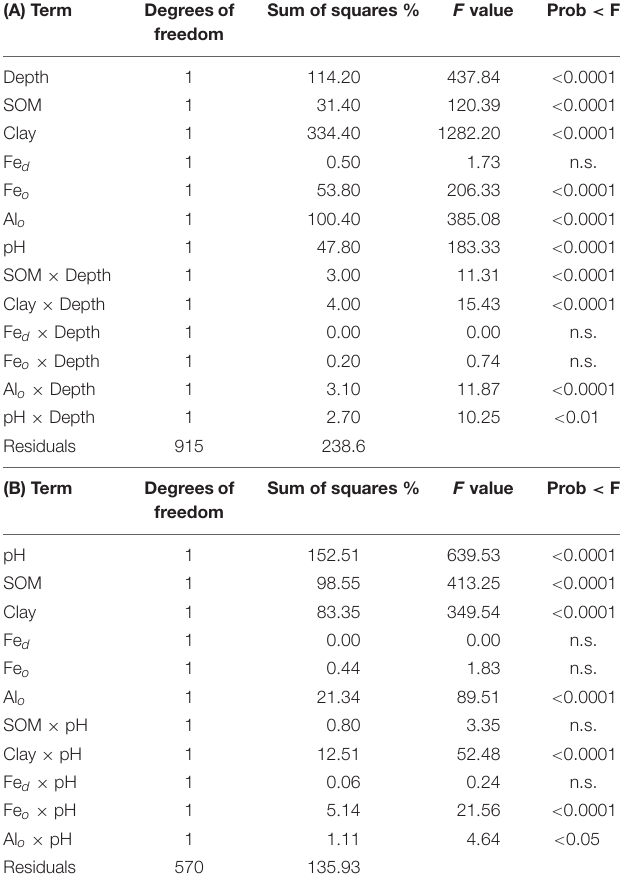
TABLE 2 | (A) Linear mixed effect model testing the effect of soil depth, soil organic matter (SOM, as a proxy of SOC), percentage of clay, pH, dithionite extractable iron (Fe d ), oxalate extractable aluminum and iron (Al o and Fe o ), as well as two-way interactions between soil physicochemical properties with depth on the effective cation exchange capacity (CEC eff.) across complete soil profiles.